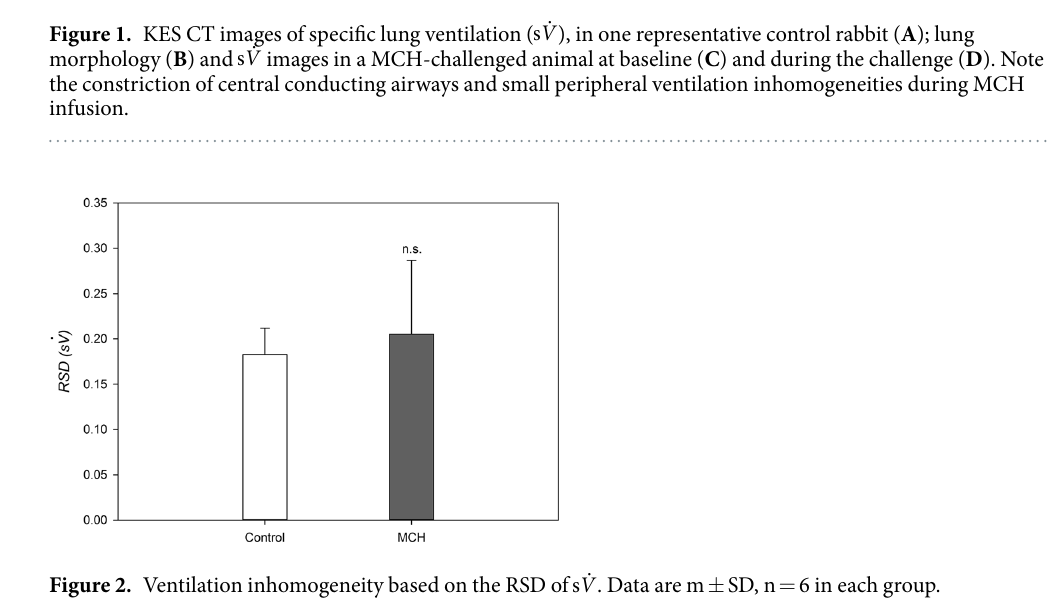
Figure 2. Ventilation inhomogeneity based on the RSD of  V s . Data are m ± SD, n = 6 in each